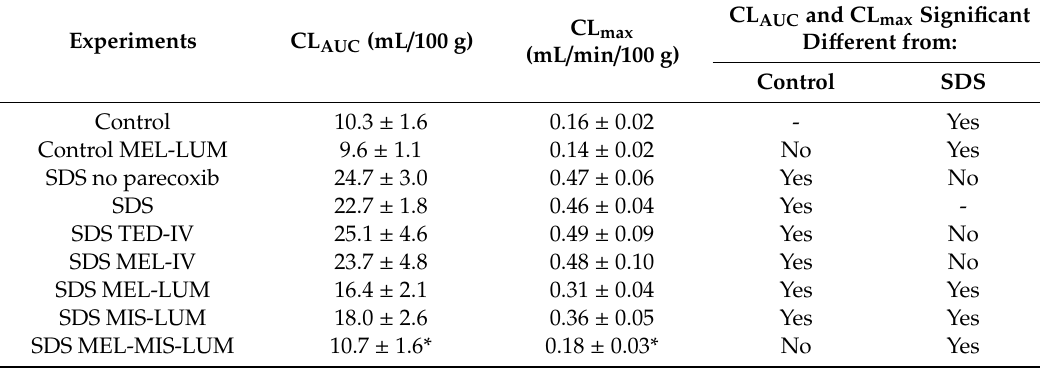
Table 1. The area under the blood-to-lumen CL Cr-EDTA time curve between 45 and 120 min (CL AUC ), and maximum CL Cr-EDTA (CL max ) in the jejunal perfusate of the nine different single-pass intestinal perfusion experiments (Table 2 and Figure 5). Three experimental drugs—melatonin (MEL), misoprostol (MIS), and teduglutide (TED)—were luminally (LUM) and/or intravenously (IV) administered, individually or in combination, to rats in order to evaluate their effects on SDS-induced mucosal damage. Differences in CL AUC and CL max compared to the control solution or the SDS solution are presented. The mark * represents a significantly lower CL AUC /CL max of the luminal combination of melatonin and misoprostol compared to melatonin and misoprostol alone. The CL AUC and CL max values were compared using a one-way ANOVA with a post-hoc Tukey’s multiple comparison test.